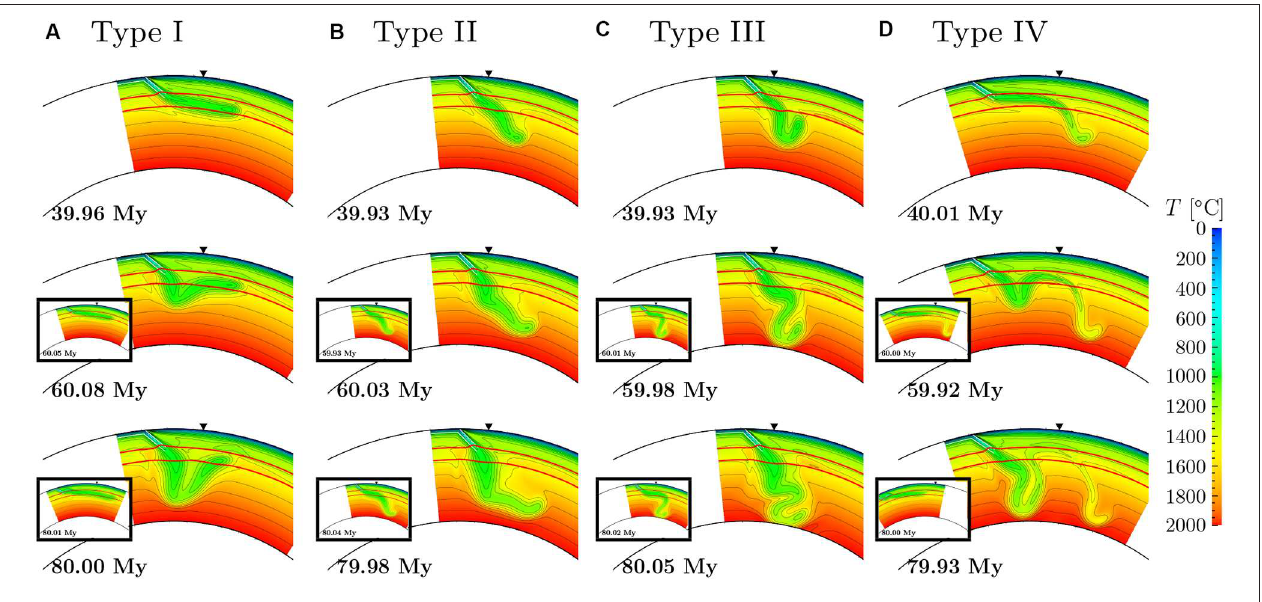
FIGURE 7 | Evolutions of slab behaviors with the sudden stop of trench retreat at around 40 My after the initiation of subduction. Snapshots of temperature distribution at 40 My (top), 60 My (middle), and 80 My (bottom) for the cases of (A) v tr MPa/K, (C) v tr 1.58 cm/yr, r η 1, γ 660 -3 MPa/K, and (D) v tr = = = behaviors with constant v tr . The meaning of the colors, contour lines, red and white lines, and black triangles are same as in Figure 2